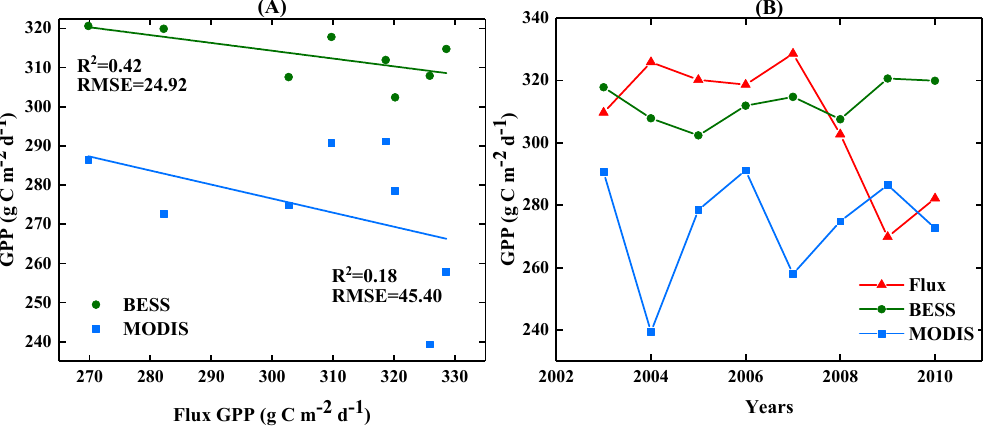
Figure 11. ( A )Evaluation of BESS GPP and MODIS GPP products against flux observations from Xishuangbanna and ( B ) the annual variability of flux GPP, BESS GPP, and MODIS GPP during the period of 2003–2010.